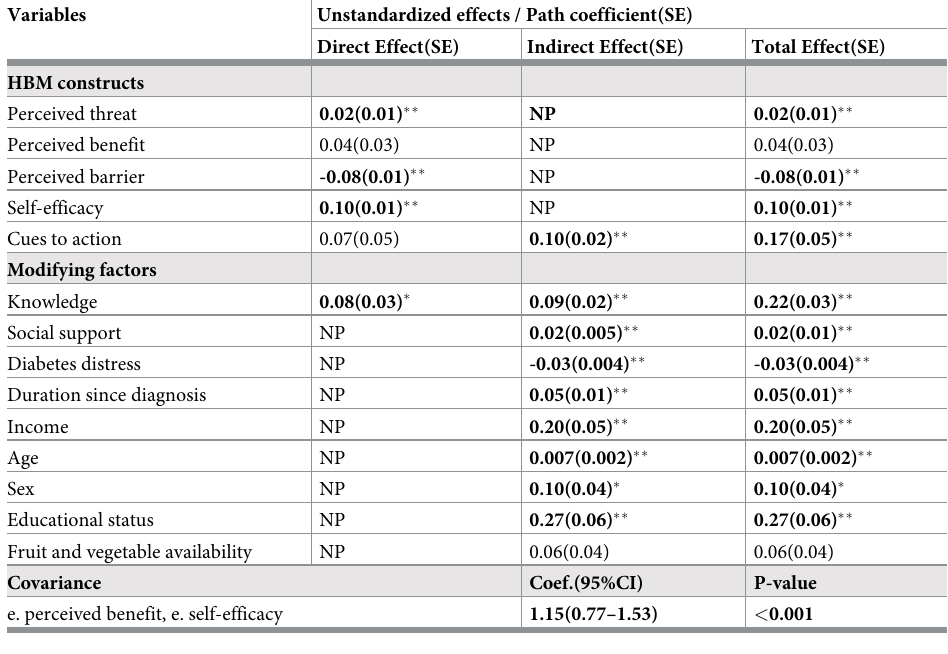
Table 6. Total, direct and indirect effects of dietary self-care practice, JUMC 2020.